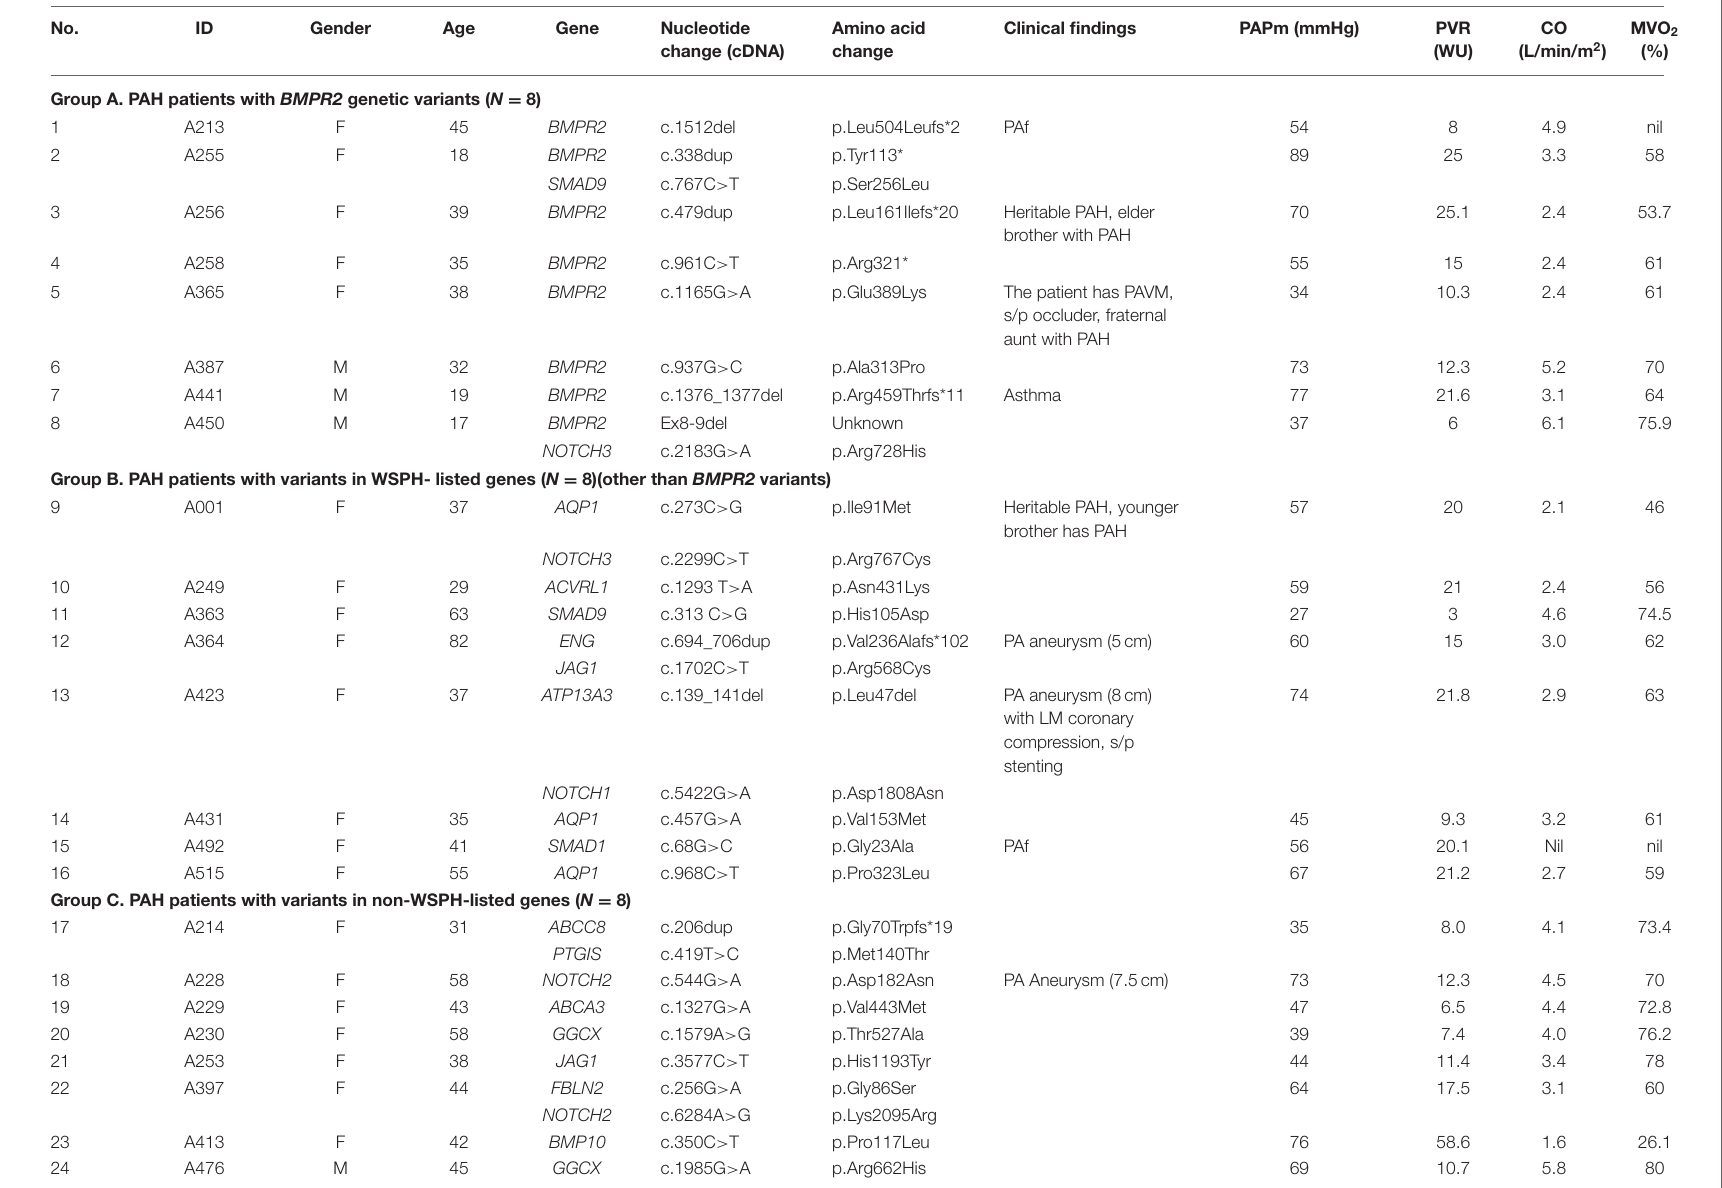
Amino acid Clinical findings PAPm (mmHg) PVR change (cDNA) change